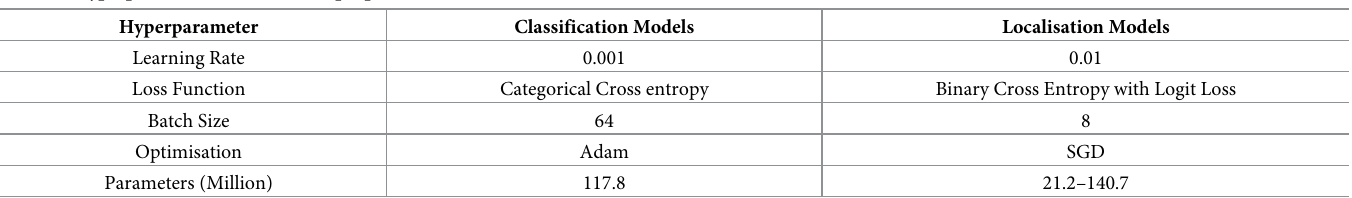
Table 2. Hyperparameter values used in proposed